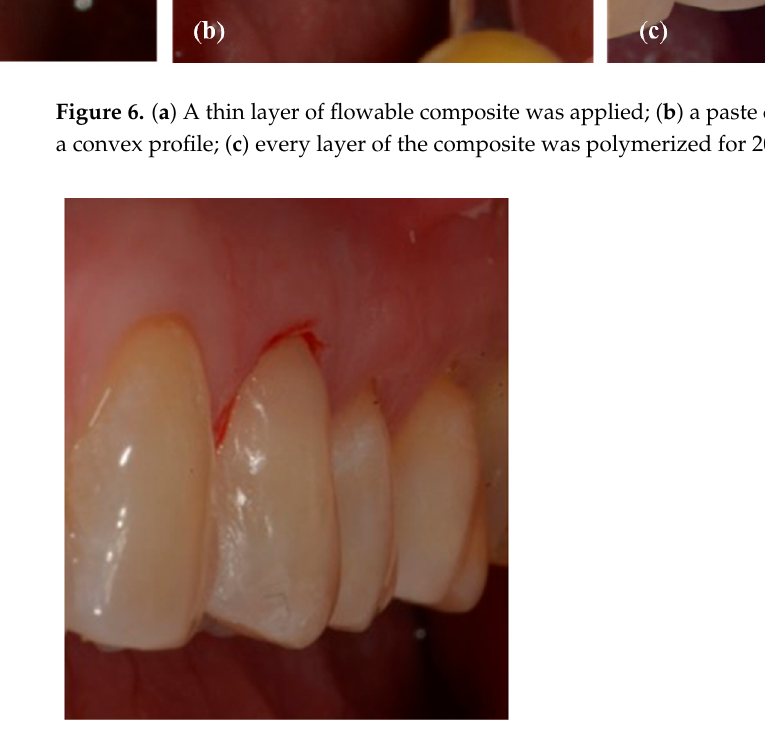
Figure 7. First refinement of the restoration and removal of the retraction cord.